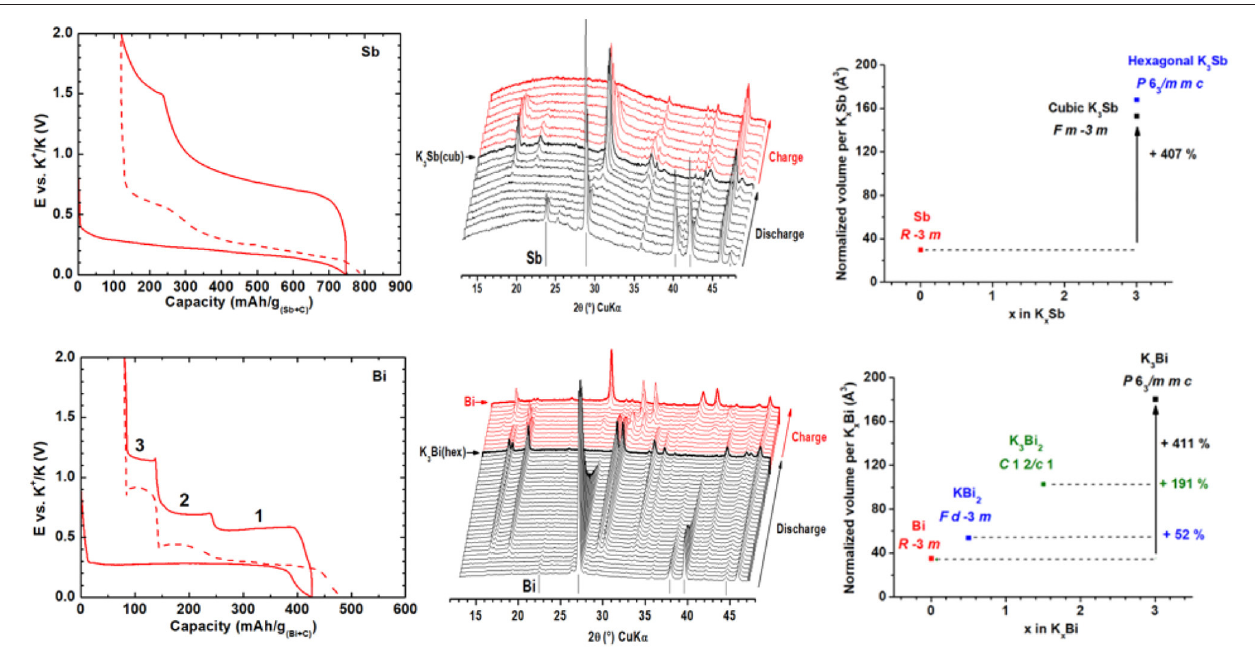
FIGURE 6 | Left, galvanostatic profiles of Sb (top) and Bi (bottom) electrode cycled at C/5 rate. Middle, operando XRD patterns recorded during the first cycle. Right, evolution of the normalized volume change upon potassiation. Reprinted with permission from Gabaudan et al. (2018a). Copyright (2018) American Chemical